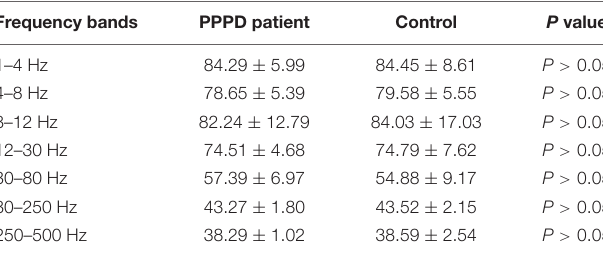
FIGURE 4 | Changes in neuromagnetic source strength in specific brain regions between two groups. * P < 0.05 after Bonferroni correction.